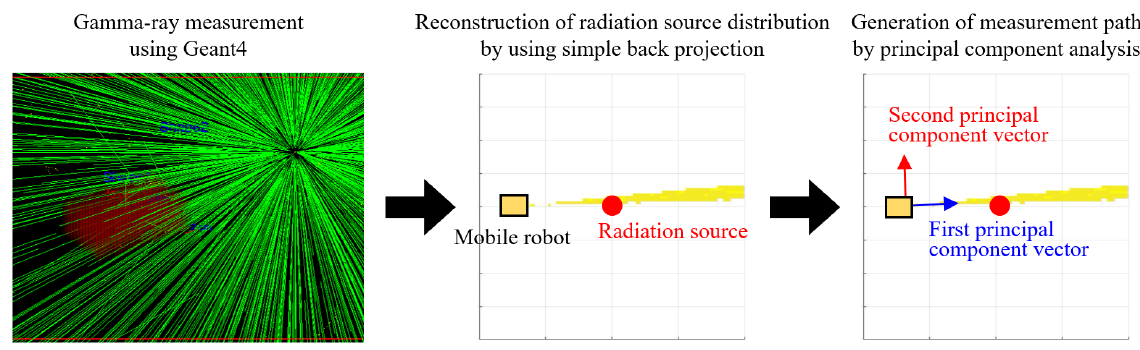
Figure 8. All-around view Compton camera implemented in Geant4: the camera consists of a 12 × 4 × 30 array of CdTe detectors. The red, green, and blue arrows represent the X -, Y -, and Z - axes, respectively.